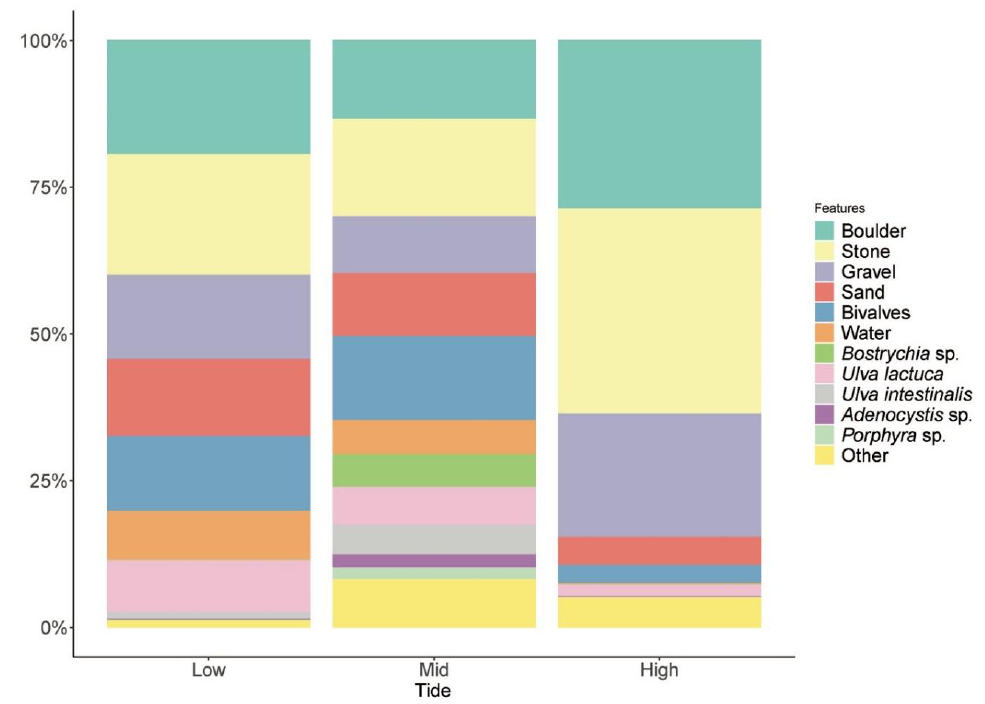
Figure 5. Stacked histogram with the distribution of the 12 measured environmental variables across the three tidal zones (low, mid and high). Insects 2020 , 11 , x FOR PEER REVIEW Differences in air temperature were significant between the three zones (χ 2 = 10.814, d.f. = 2, p = 0.002), with temperatures in the mid tide being significantly higher than the high tide ( p = 0.002). Air R.H. was not significantly different between zones (χ 2 = 4.457, d.f. = 2, p = 0.108). Substrate surface